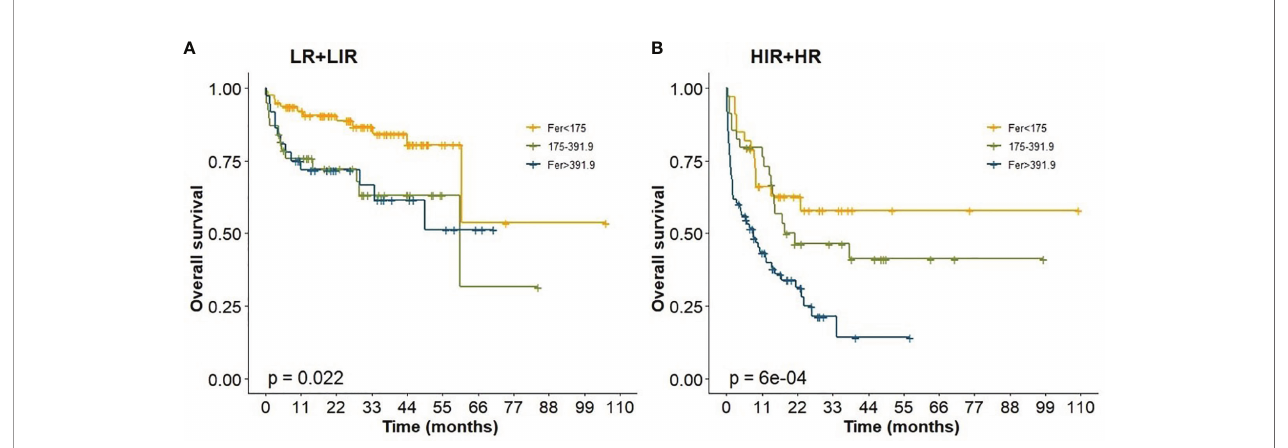
FIGURE 5 | Prognostic impact of ferritin levels among patients in IPI. (A) Low risk/low intermediate risk group; (B) high intermediate risk/ high